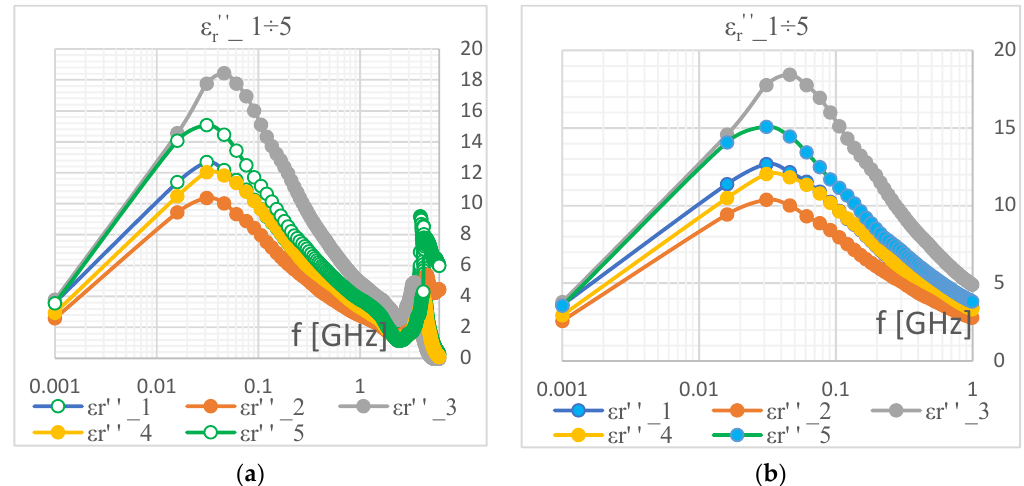
'' ε '' ε '' of permittivity for samples #1 ÷ #5 and the following ranges of f: ε of permittivity for samples #1 ÷ #5 and the following ranges of f: r r of permittivity for samples #1 ÷ #5 and the following ranges of f: r